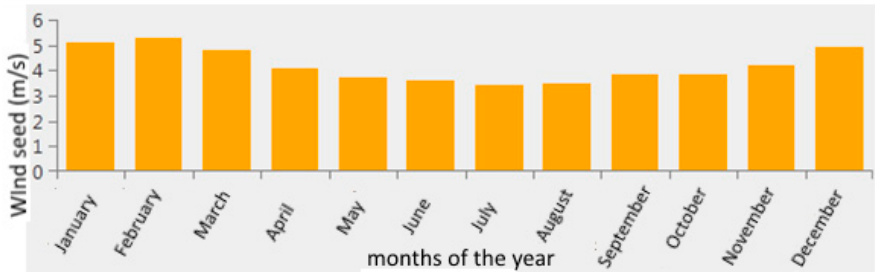
Figure 4. Wind speed data.